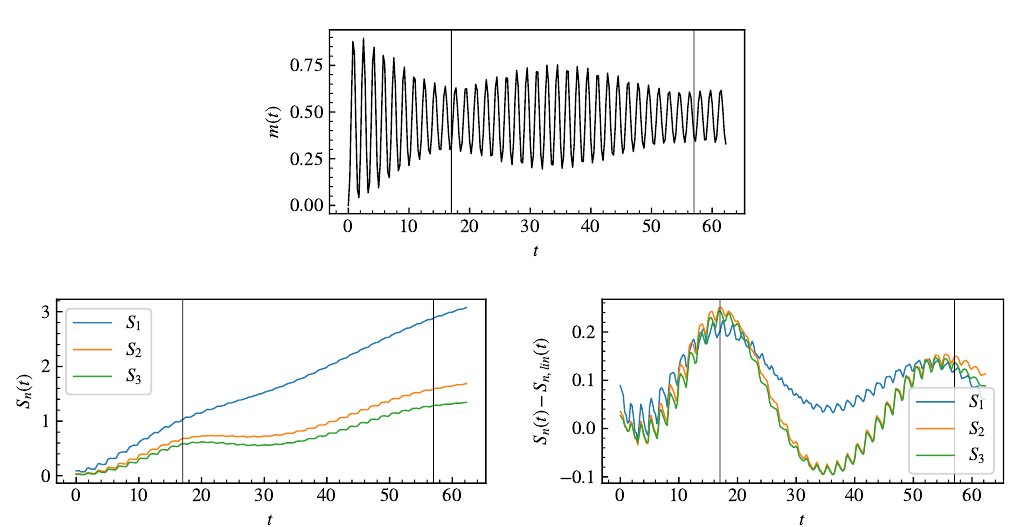
Figure 4.3: Time evolution of various quantities after a large quench ( g ) = ( 2.0,0.0 ) → ( g , h ) = ( 2.0,0.7 ) in the quantum Ising spin chain. The , h 0 0 top left diagram shows the evolution of magnetisation, the top right one the von Neumann entropy ( S ) and two of the Rényi entropies ( S 1 one shows the entropy evolution with the linear trend subtracted. The vertical lines correspond to a single period of the slow oscillation corresponding to the frequency − m 2 m . The first line is drawn at the first minimum of the envelope of the magneti- 1 2 sation oscillations while second is drawn at a distance given by the period T ≈ 40. Note that their position matches quite well the behaviour of the entropy curves as well. Time is measured in units of 1 / J , and the initial entropy was